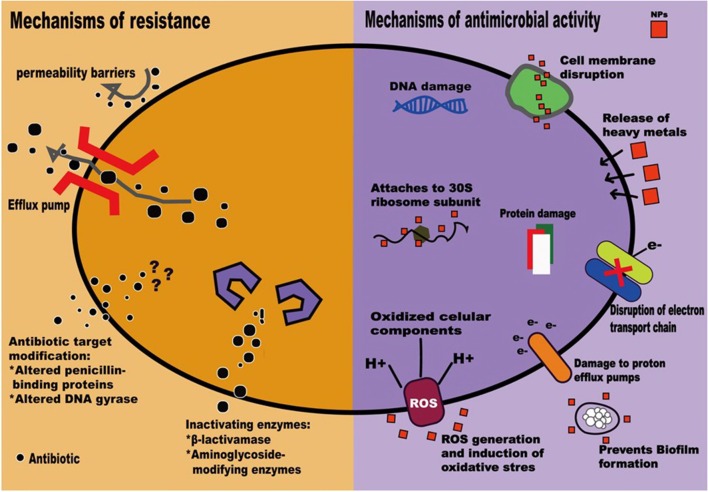
Mechanisms of antimicrobial resistance (Mulvey and Simor, 2009) and actions of nanoparticles (Baptista et al., 2018).